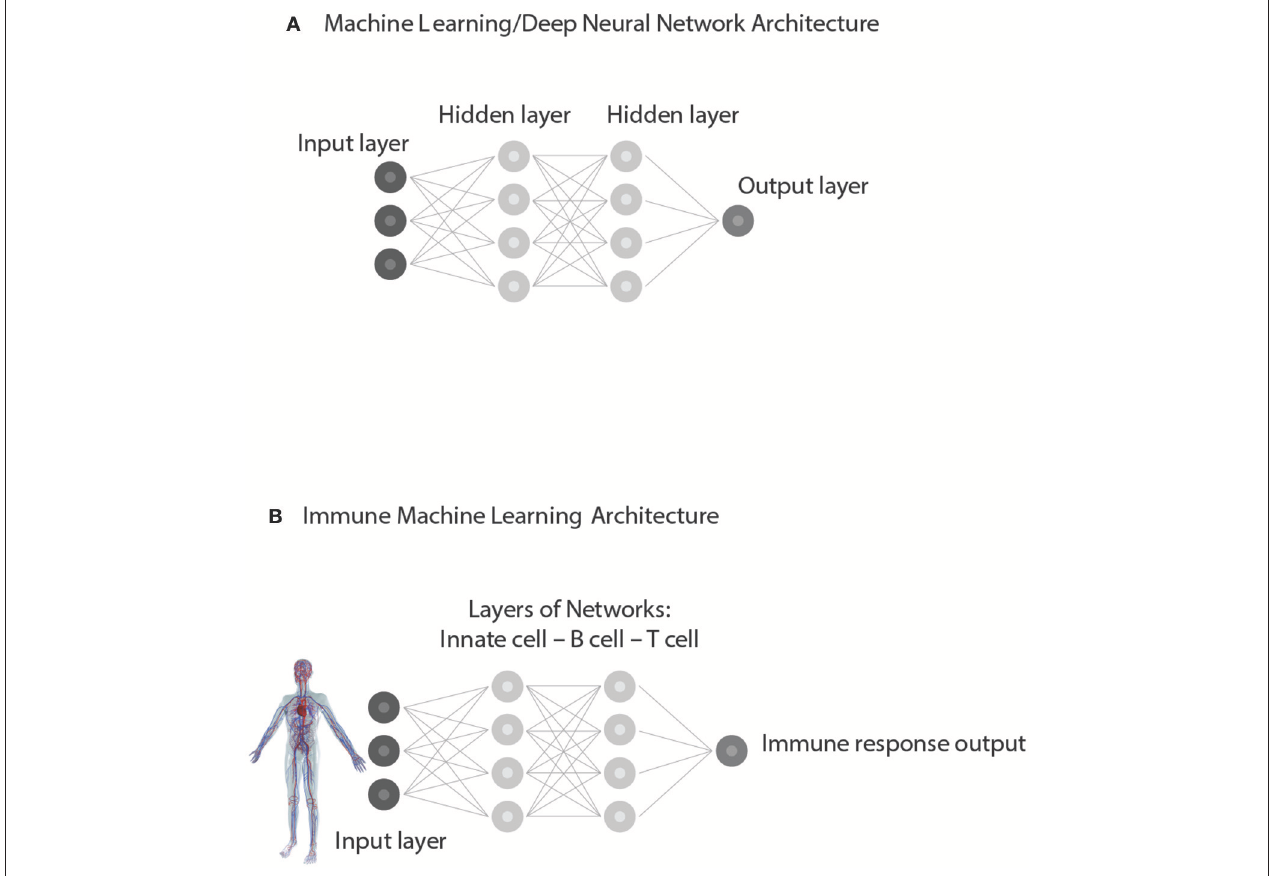
FIGURE 5 | Supervised Machine learning from experience. (A) represents a simplified Architecture of computer Machine Learning in which Hidden Layers of interacting networks are organized as Deep Neural Networks. Input information is interpreted by comparing the present test Input to training sets of information previously experienced. The processing of test Input through hidden layers of networks generates an informative Output. (B) represents an analogous Immune supervised Machine Learning Architecture. Input from the body—healthy or ill—is gathered by receptors of immune cells and processed through interactions organized as hidden layers of networks of Innate cells, B cells, and T cells. By comparing the input data to the training data obtained during immune cell development, the immune system generates an immune response suitable to the situation. The output feeds back to serve the needs of the body and to update the internal organization of the immune networks